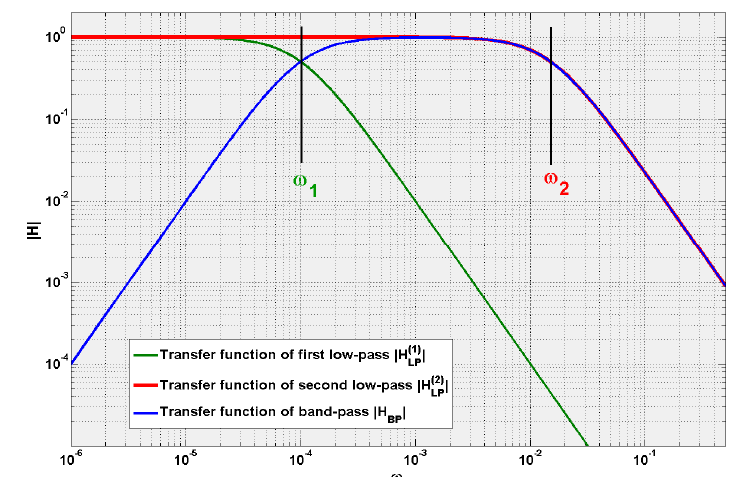
Figure 3. Transfer functions of the two low-pass filters and the band-pass filter. The cut-off frequencies w 1 and w 2 define the frequency range of the